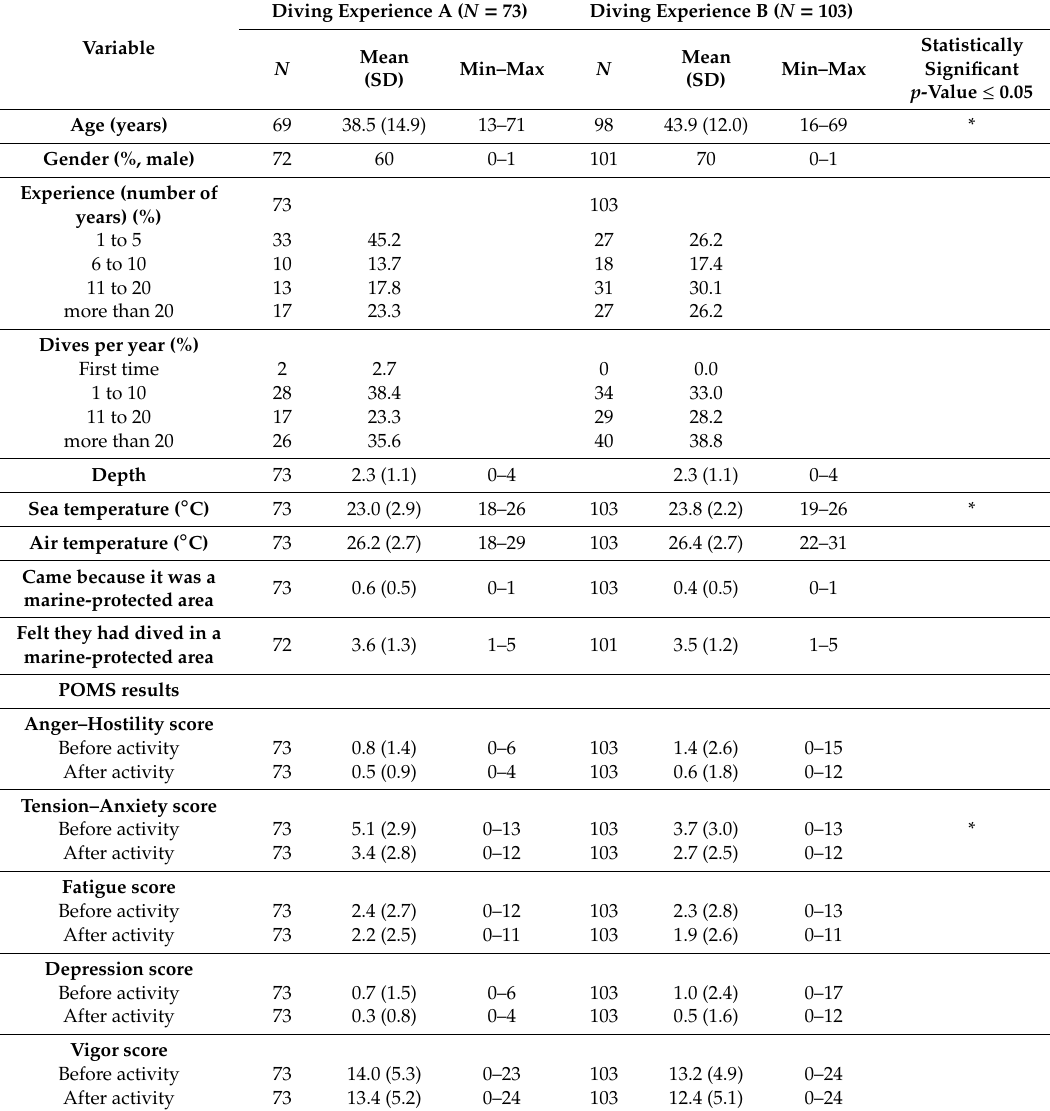
Table 3. Description of the scuba diving groups according to diving experiences a,b